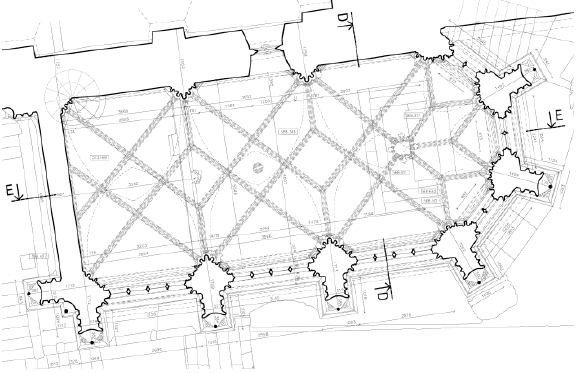
Figure 25. Ground plan section of the Zápoľský chapel